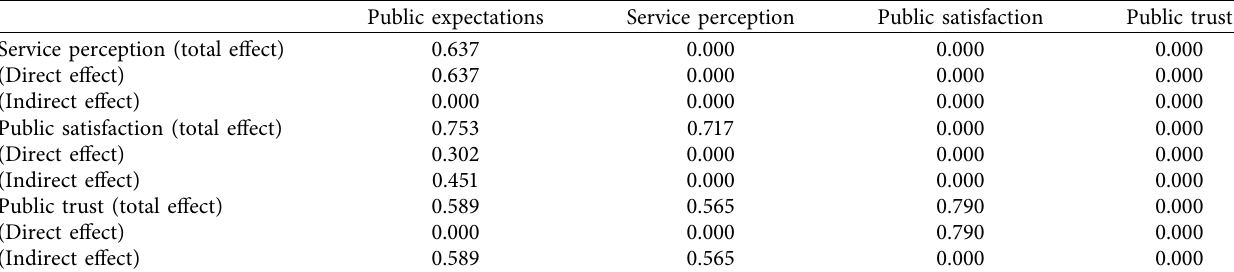
Table 11: Estimates of standardization